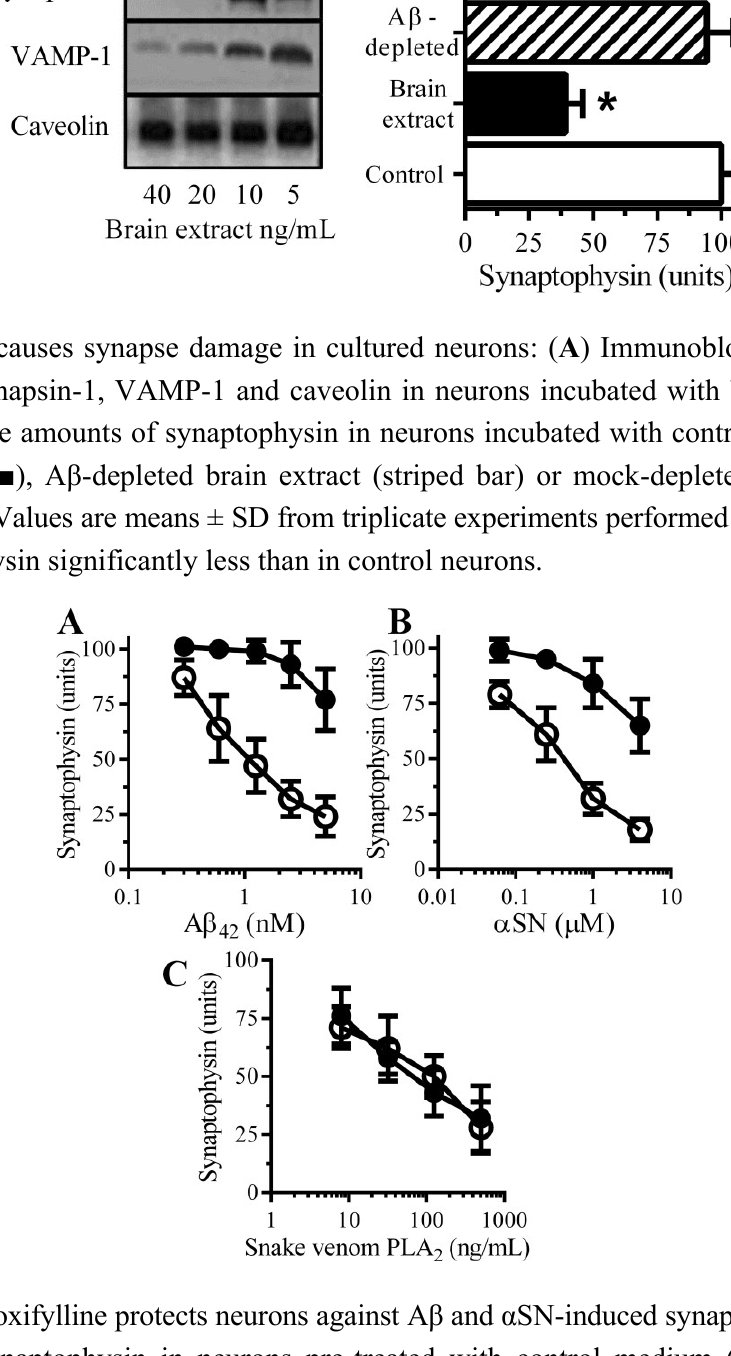
Figure 2. Pentoxifylline protects neurons against Aβ and αSN-induced synapse damage: The amounts of synaptophysin in neurons pre-treated with control medium (○) or 100 µM pentoxifylline (●) and incubated with Aβ 42 ( A ), αSN ( B ) or snake venom PLA 2 ( C ) as shown. Values are means ± SD from triplicate experiments performed 3 times ( n =